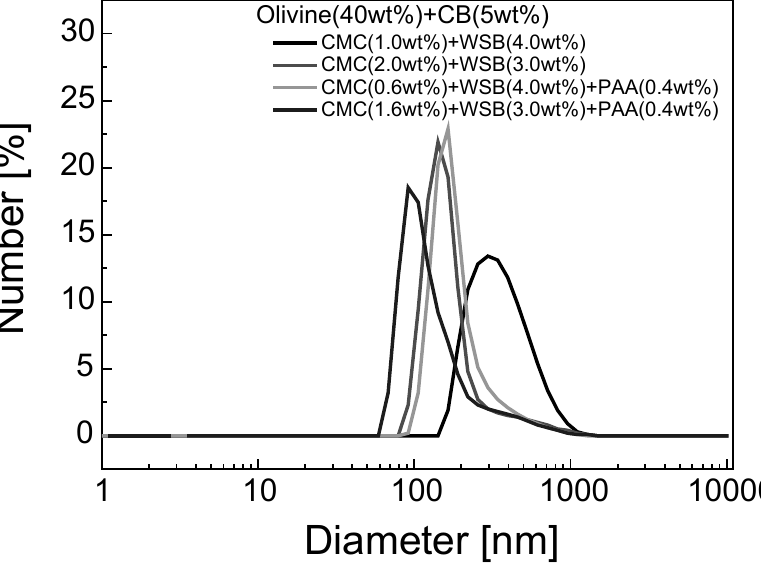
Fig. 2 Particle size distribution of 5wt%-diluted C/LiFePO 4 containing CMC and WSB with and without PAA.